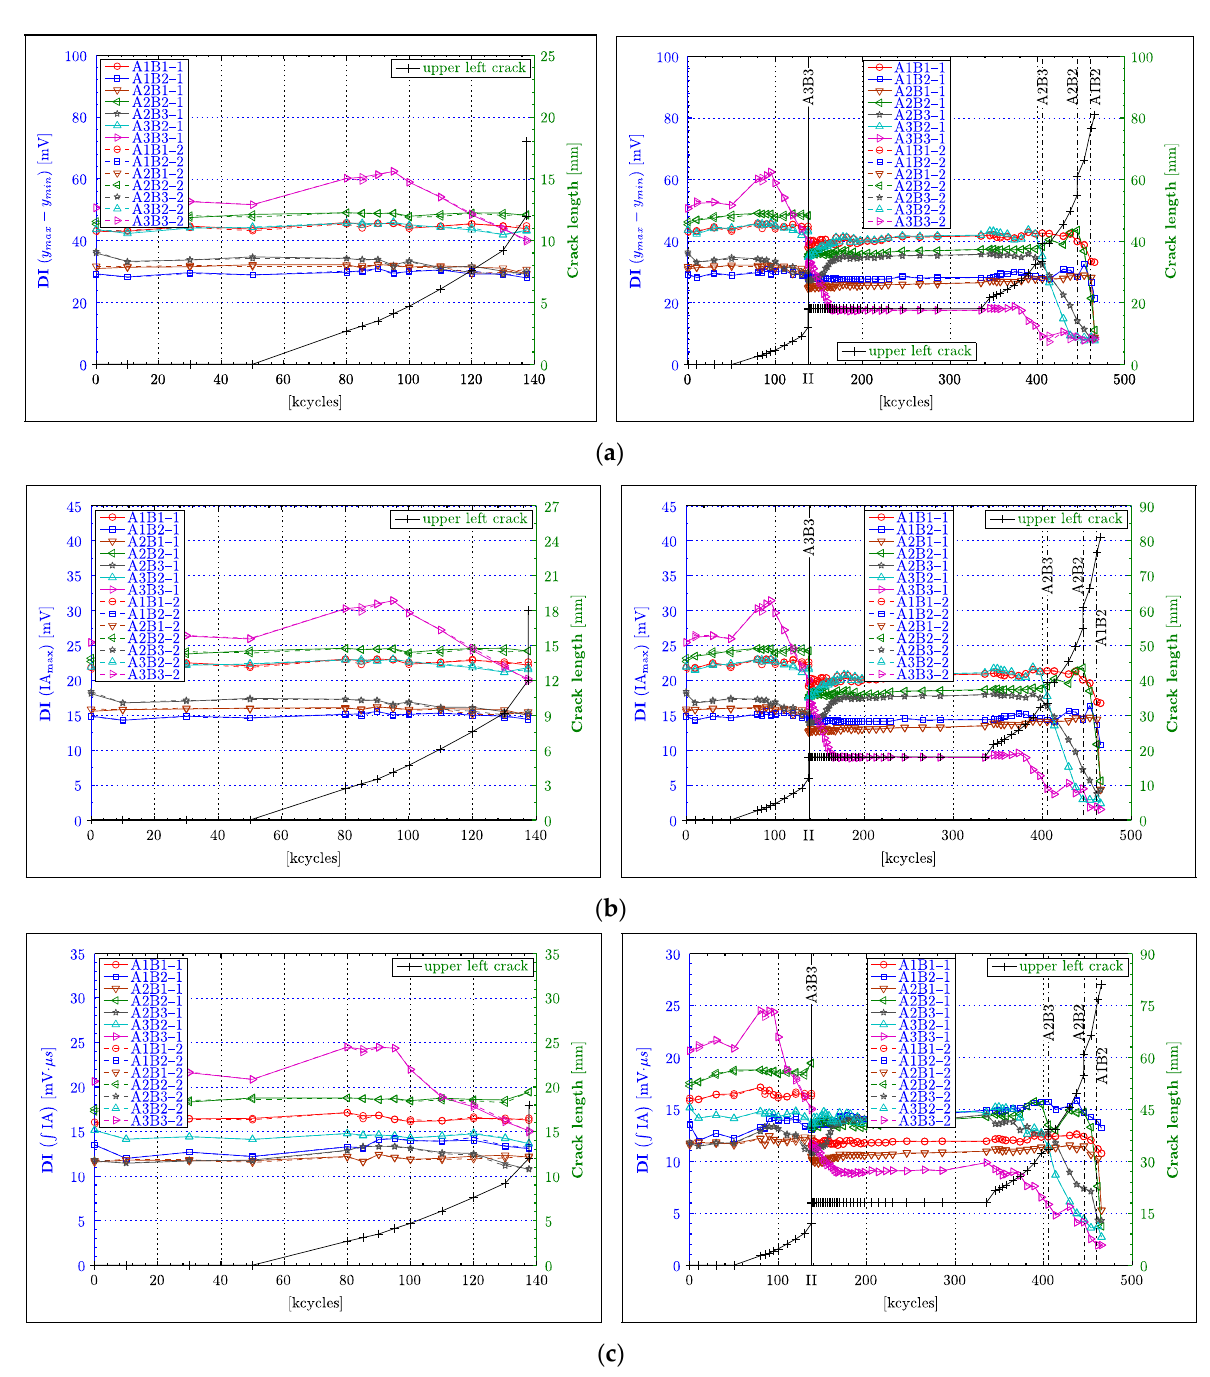
lope); ( c ) integrated instantaneous amplitude. The left column gives the results corresponding to only the PHASE 1 experimental test (from 0 to 147,500 fatigue cycles only) whereas the right column presents the results for the PHASE 1 and PHASE 2 experimental tests. The thin vertical solid line (described by the symbol “II”) separates the two experimental tests (PHASE 1 and PHASE 2) inves- tigated.